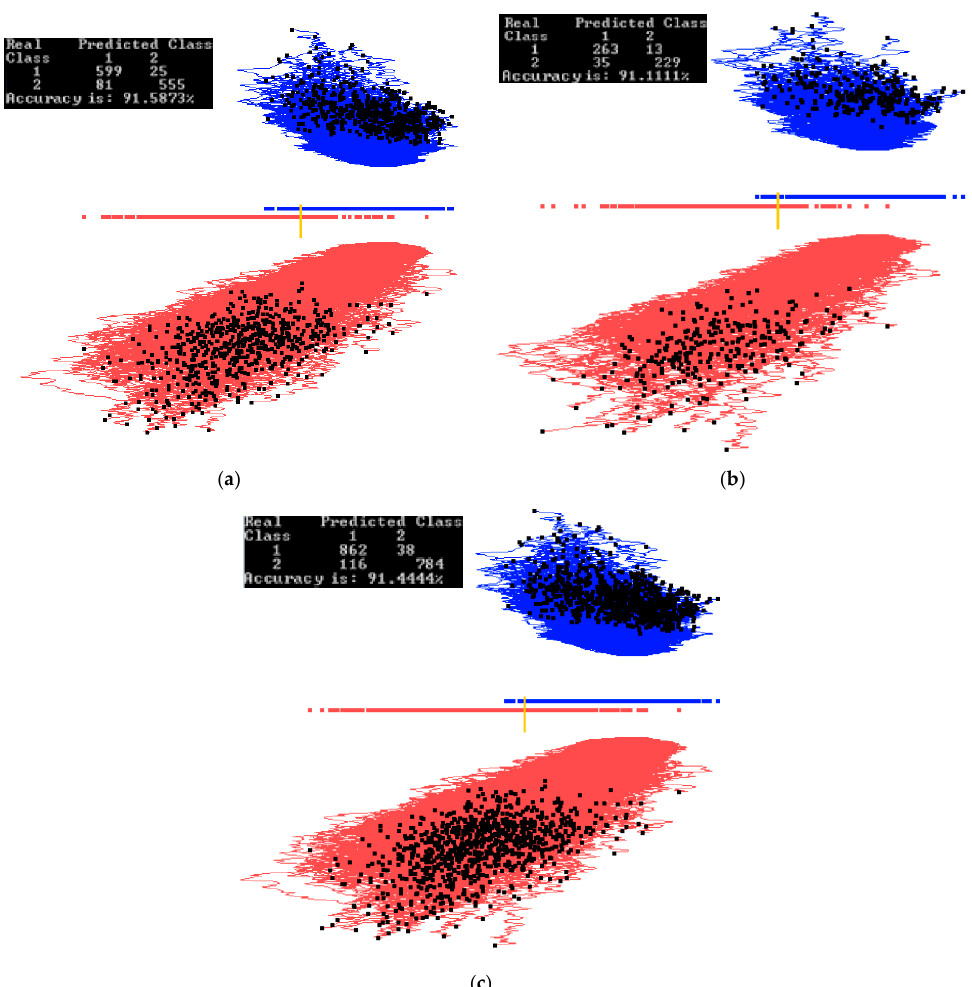
Figure 14. MNIST subset for digits 0 and 1 data set showing training, validation, and the entire data set when trained on the training set. ( a ) Data is split. Using 70% (training set) to find the coefficients. Projecting training set, best from the first runs of GLC-A; ( b ) Using the coefficients found by the training set in (a) and projecting the validation dataset (30% of the data); ( c ) Projecting the entire data set using the coefficients found by the training set in (a).